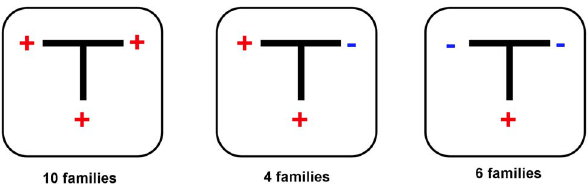
Figure 1. SV40 sequences in pedigrees of FA probands positive to SV40. DNA samples of parents were available for 20 families. In the trios, individuals positive to SV40 are indicated with ‘‘ + ’’ (red) and those negative with ‘‘ 2 ’’